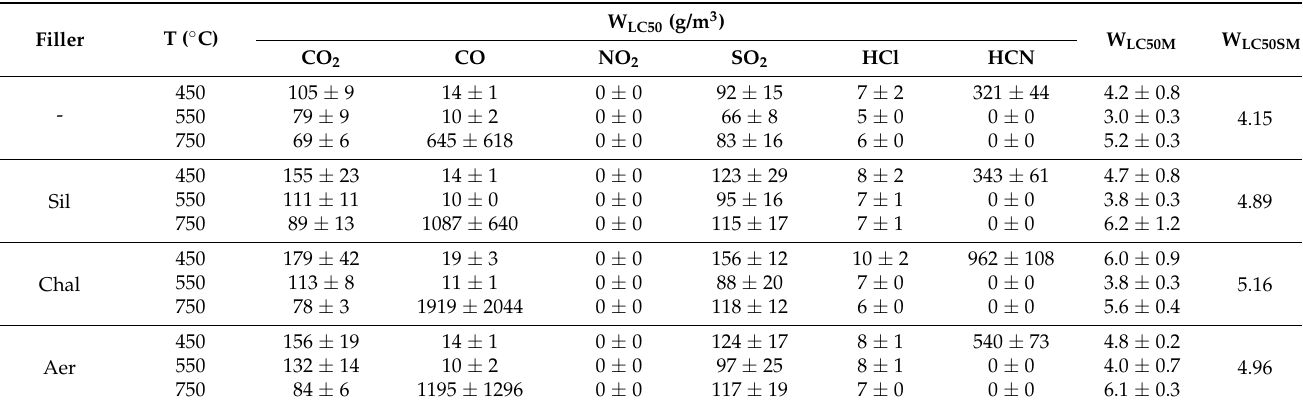
Table 6. Toxicometric indicators of unfilled and filled vulcanizates determined at the temperatures of 450, 550 and 750 ◦